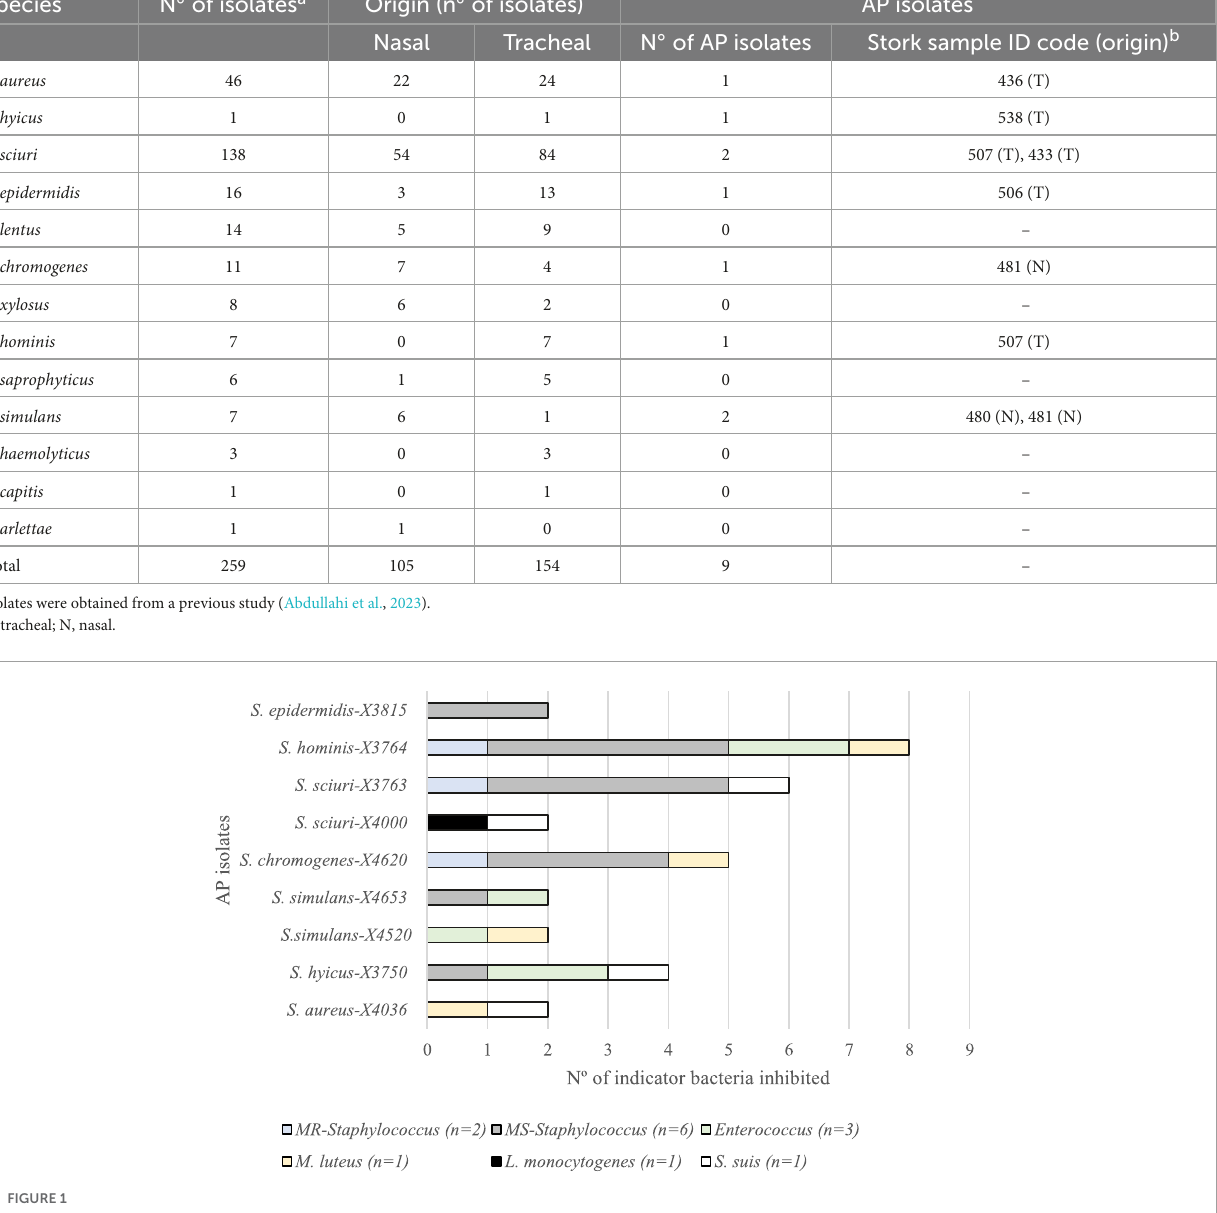
TABLE 1 Staphylococcal isolates evaluated a for antimicrobial activity by the spot-on-lawn method against 14 indicator bacteria and antimicrobial-producing (AP) isolates detected. Species N ◦ of isolates a